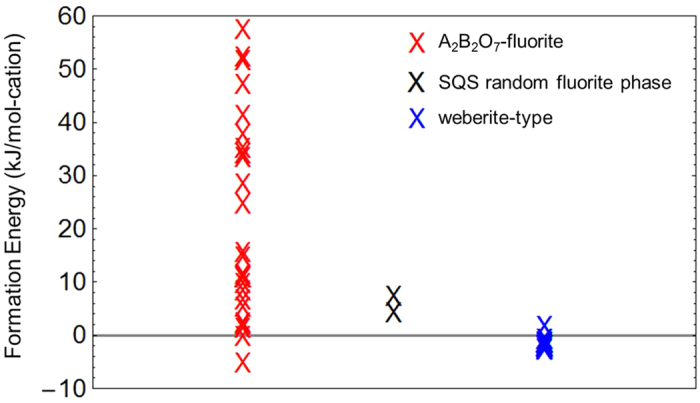
Formation energies (kJ/mol-cation) of all enumerated structures.A2B2O7-fluorite, weberite-type configurations, and the 88 atom (ΔHf = 7.2 kJ/mol-cation) and 297 atom (ΔHf = 4.0 kJ/mol-cation) SQS models of a random fluorite phase for Ho2Zr2O7 are shown.